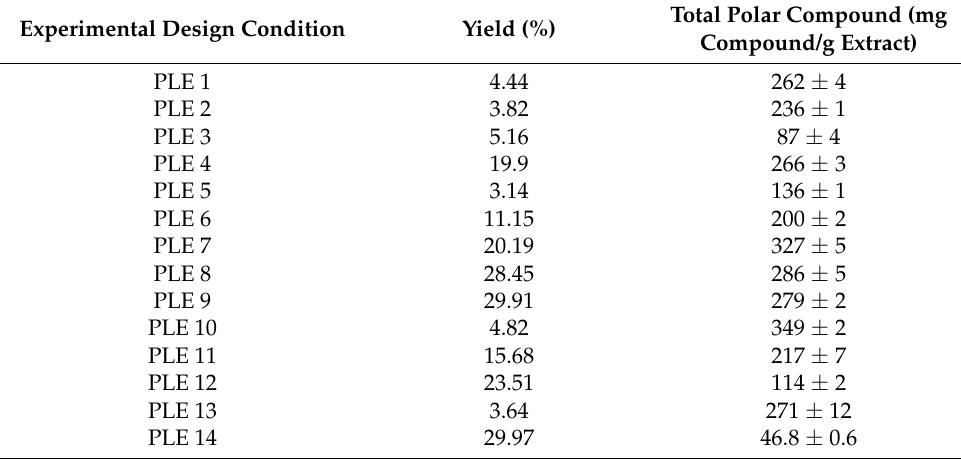
Table 4. Extraction yield and quantitative results of PLE central composite 2 3 experimental design expressed in mg compound/g extract of C. grandis seed (X ±